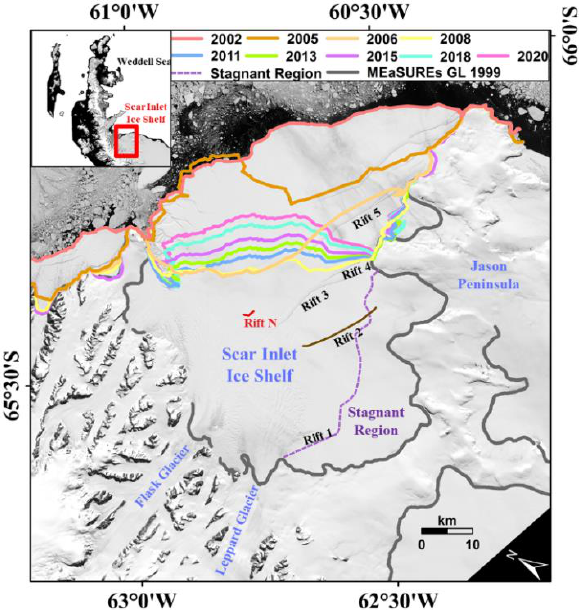
Figure 1 . Study area of the Scar Inlet Ice Shelf and its tributary glaciers on 18 December